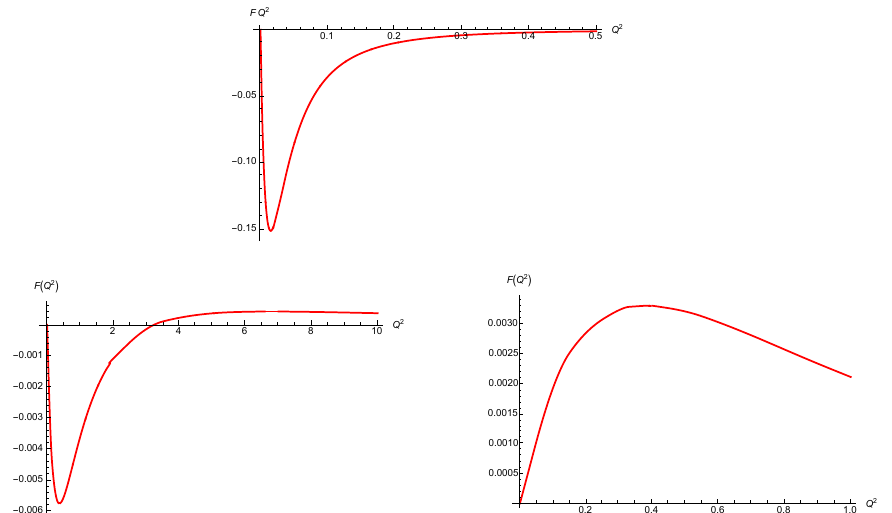
Figure 17. Transition form factors between the following states taken from Table 1. (Adapted from [1]). Upper panel: abnormal (No. 3, n = 1, κ = 2) → abnormal (No. 4, n = 2, κ = 2). Lower left panel: normal (No. 2, n = 2, κ = 0) → abnormal (No. 3, n = 1, κ = 2). Lower right panel: normal (No. 2, n = 2, κ = 0) → abnormal (No. 4, n = 2, κ =